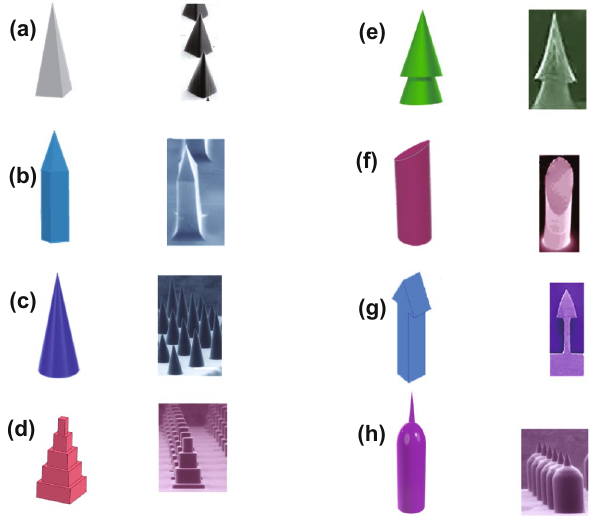
Fig. 10 Different microneedle designs and their constructed needles. The SEM images of part a [135], b [136], c [135], d [137], e [138], f [139], g [140] and h [135] reprinted with